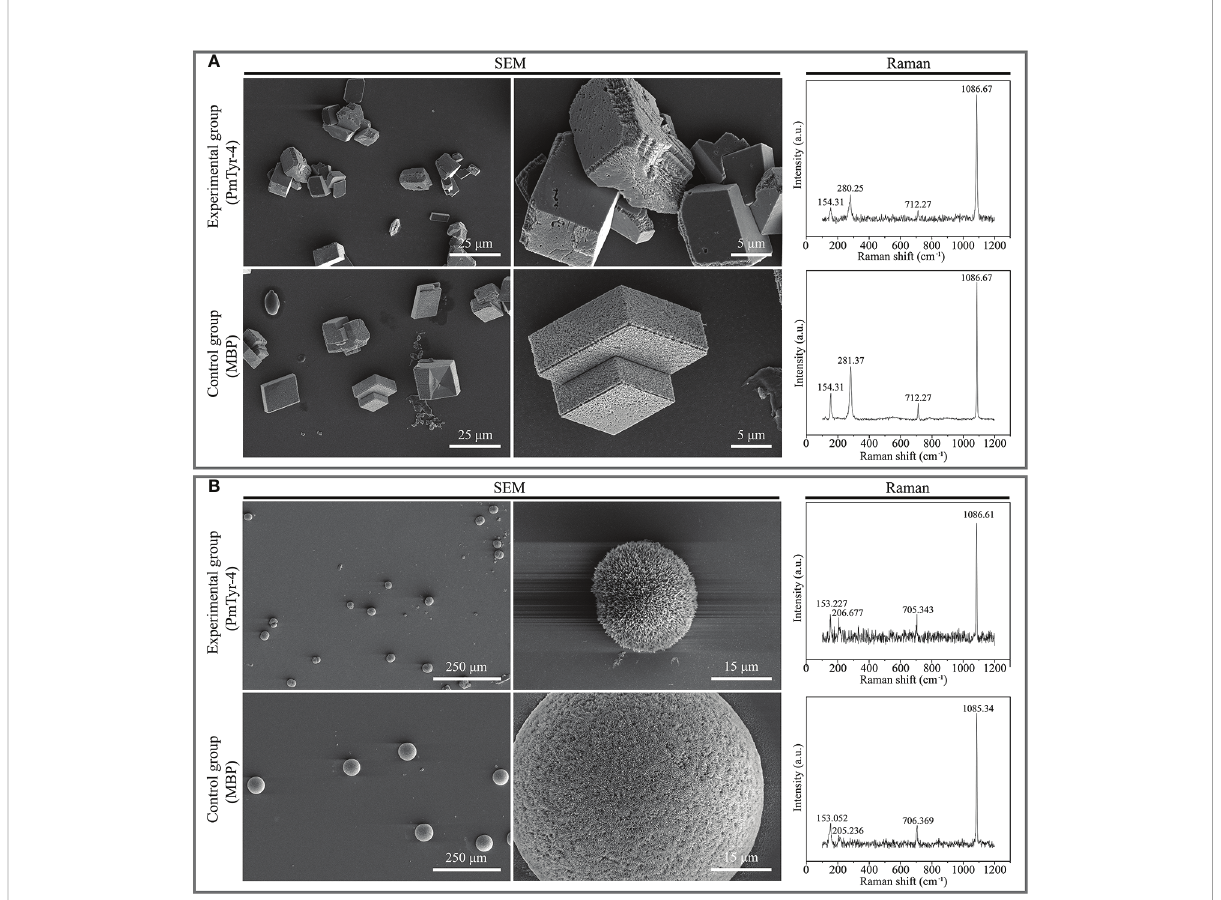
FIGURE 8 Effect of rPmTyr-4 on the crystallization of calcite and aragonite. (A) SEM images and Raman identi fi cation of crystals in the calcite- crystallization system; (B) SEM images and Raman identi fi cation of crystals in the aragonite-crystallization system. The white line in the image indicates the scale